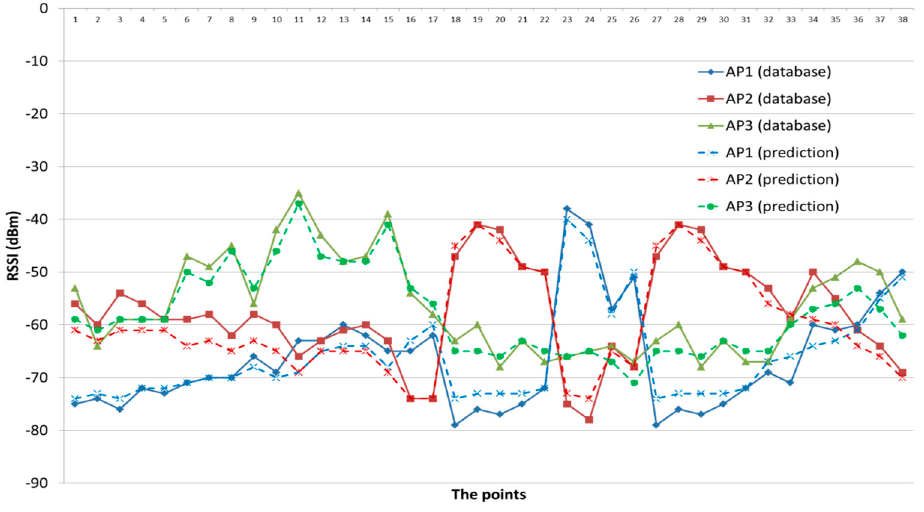
Figure 13. The database and prediction of RSSI.